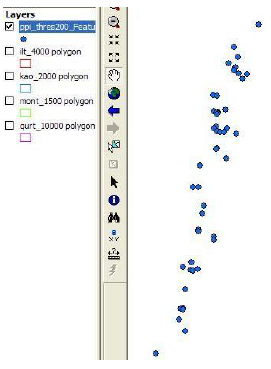
Fig 6 PPI locations of the study